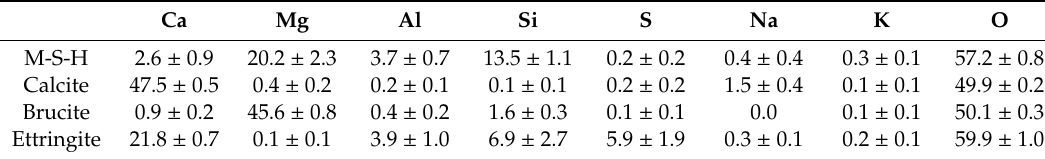
Table 11. Average and standard deviation SEM EDX composition in atomic% of at least 10 points measured in the self-healing products and M-S-H visible in Figure